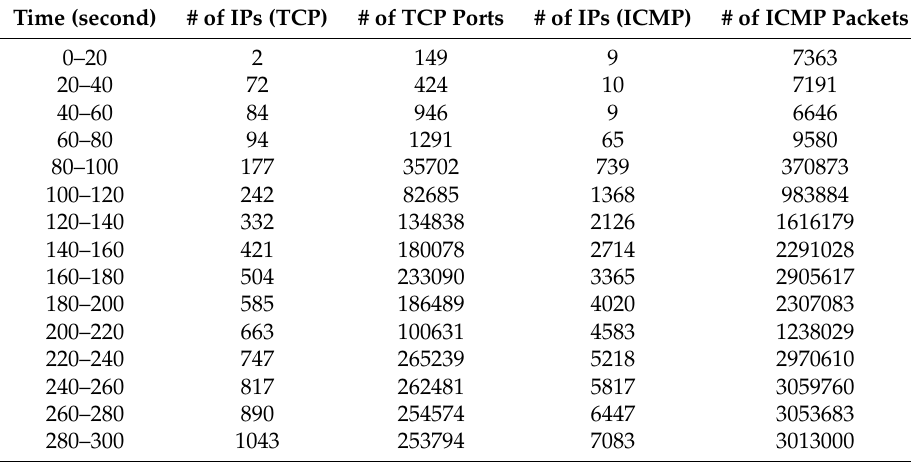
Table 1. Number of active IPs and ports in CAIDA 2007 dataset.